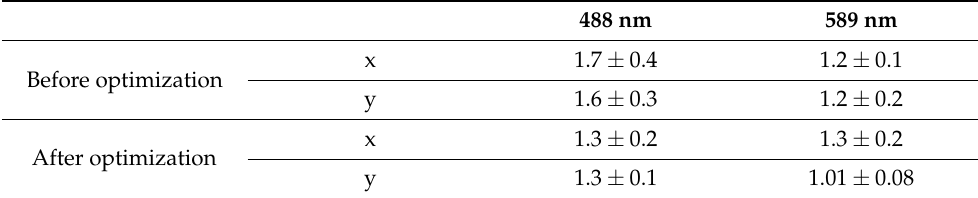
Table 1. Beam waist diameters before and after aberration correction, normalized to the diffraction limit according to Equation